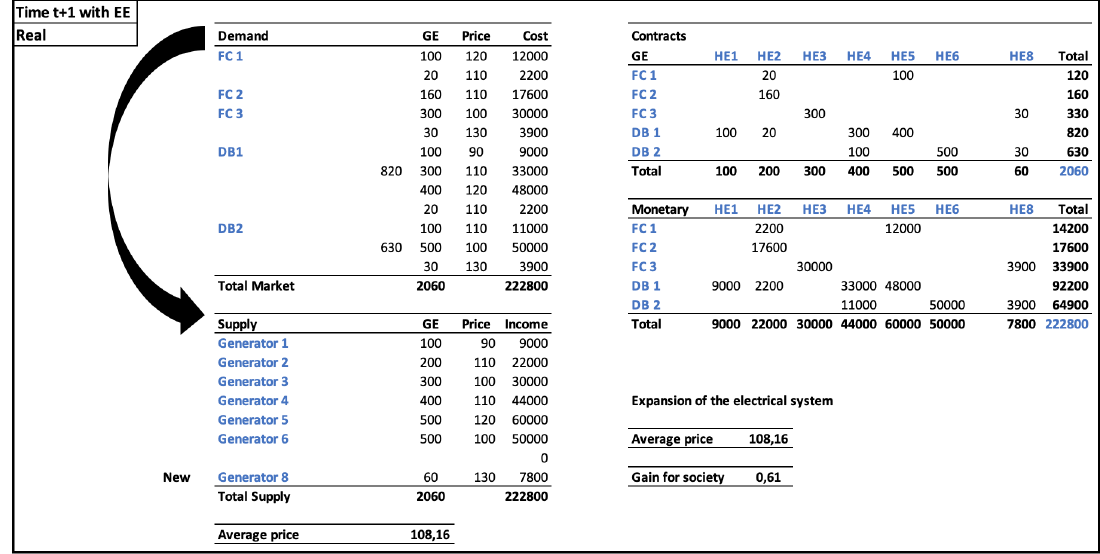
Figure 5. Evolution from time t to time t + 1 considering